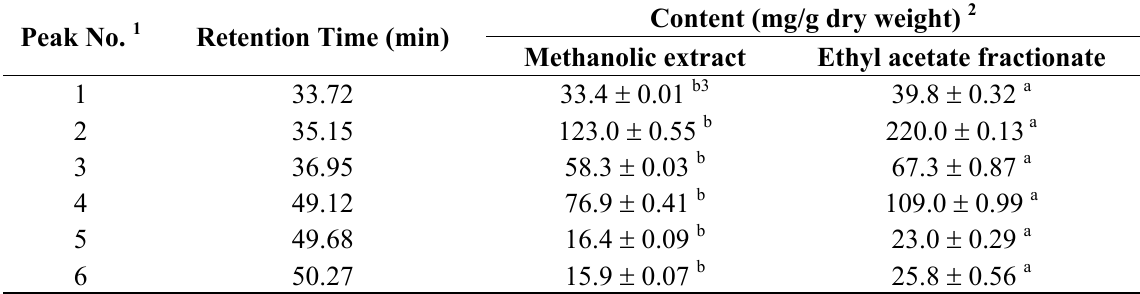
Table 2. Content of the six major components from methanolic extract and its ethyl acetate fractionate of Bidens pilosa